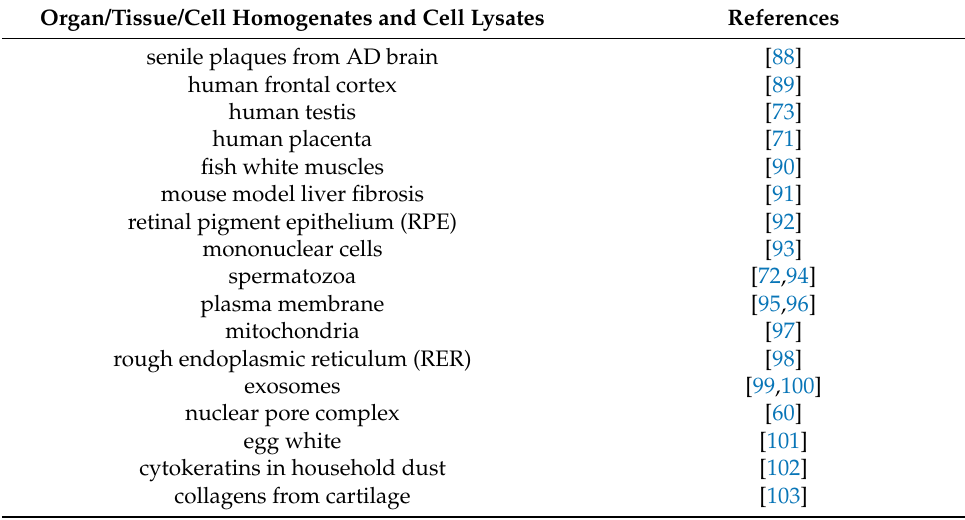
Table 3. Applications of MALDI-MS/MS for off-tissue